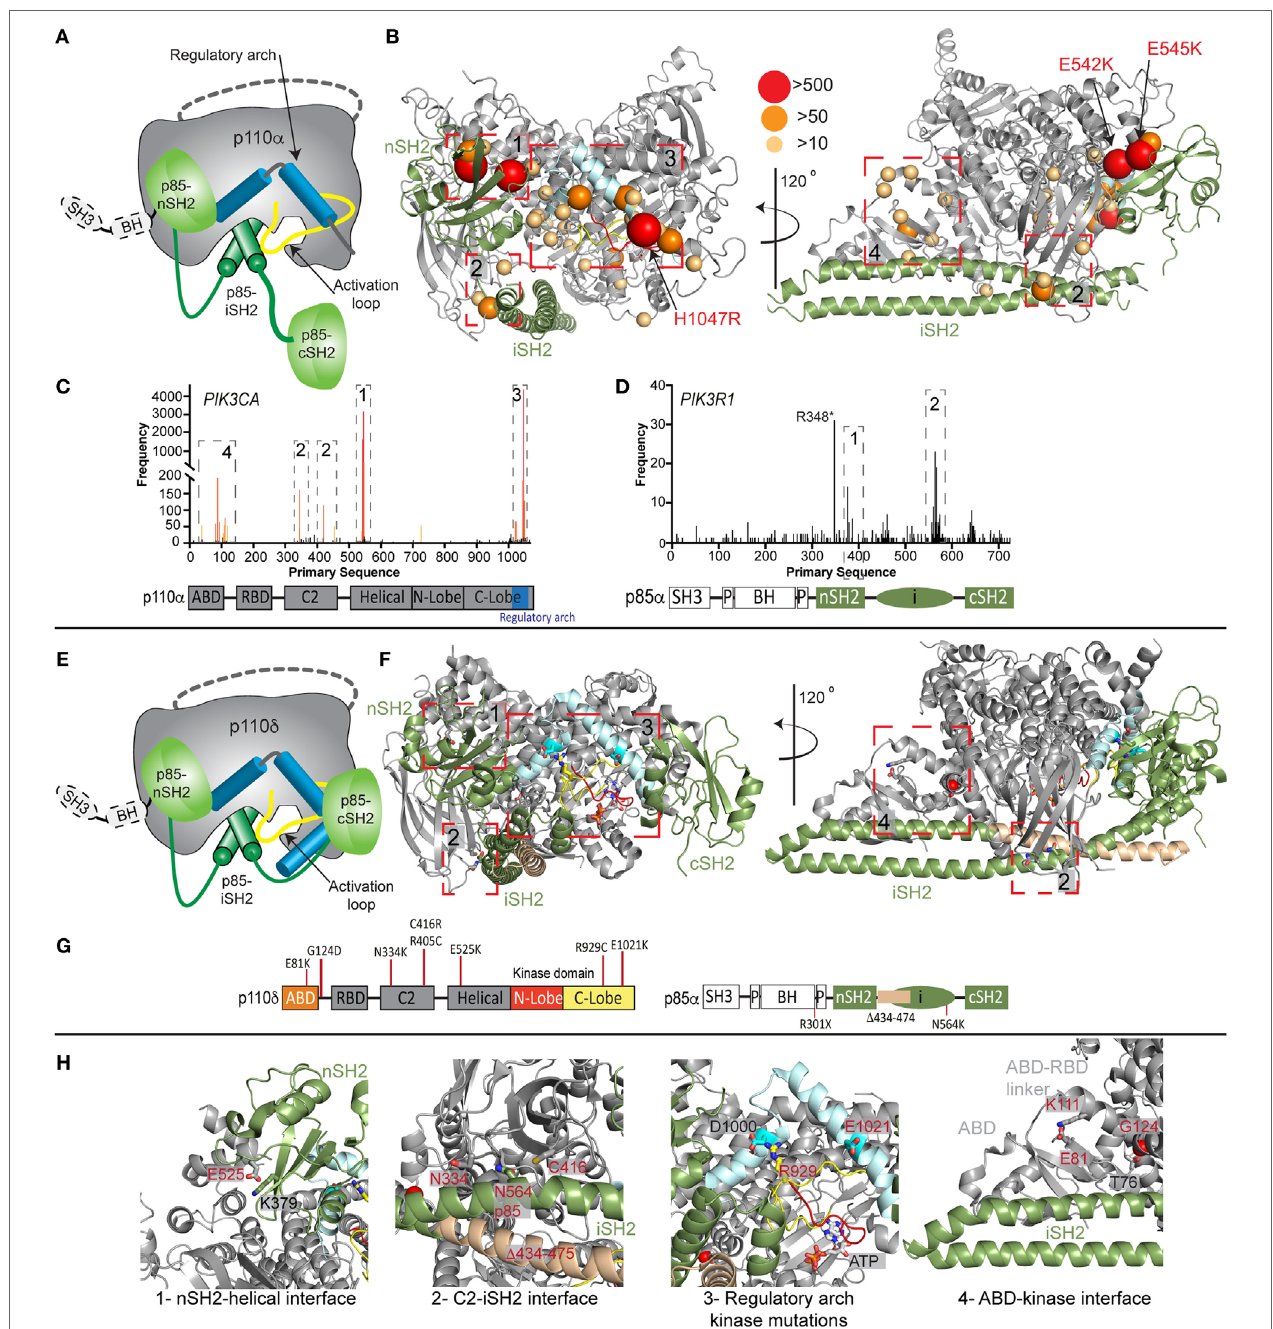
FiGURe 2 | Oncogenic and primary immunodeficiency mutations in PIK3CA , PIK3CD , and PIK3R1 . (A) Cartoon schematic of the complex between p110 α and p85 α with key regulatory features annotated. (B) The locations of oncogenic mutations in PIK3CA are shown on a structural model of p110 α and p85 α (24), with the frequency of mutations annotated according to the legend [frequency derived from the Catalogue of Somatic Mutations in Cancer (COSMIC), http://cancer. sanger.ac.uk/cosmic]. The proteins are colored according to the cartoon in panel (A) . Regulatory interfaces [N-terminal SH2 domain (nSH2)–helical, C2–inter SH2 (iSH2), regulatory arch, and adaptor binding domain (ABD)–kinase] are boxed and numbered. Boxed regions 1–4 represent mutation hotspots in key regulatory regions. These are enlarged in panel (H) in the context of patient mutations in p110 δ and p85 α . (C,D) Frequency of somatic mutations in PIK3CA and PIK3R1 shown on the primary sequence, with the domain schematic indicated below. The locations boxed on the structure in panel (B) are also indicated on primary sequence. (e) Cartoon schematic of the complex between p110 δ and p85 α with key regulatory features annotated. (F) The locations of primary immunodeficiency mutations in PIK3R1 are shown on a structural model of p110 δ and p85 α (23). Boxed regions 1–4 represent mutation hotspots in key regulatory regions. These are enlarged in panel (H) in the context of patient mutations in p110 δ and p85 α . (G) Domain schematic of p110 δ and p85 α with locations of immune-linked mutations in PIK3CD and PIK3R1 indicated. (H) Zoom in on molecular details of activating phosphoinositide 3-kinase (PI3K) delta syndrome mutations in p110 δ and p85 α , focused on the regulatory interfaces boxed in panel (F) , with all mutated residues and their interacting residues shown as sticks.